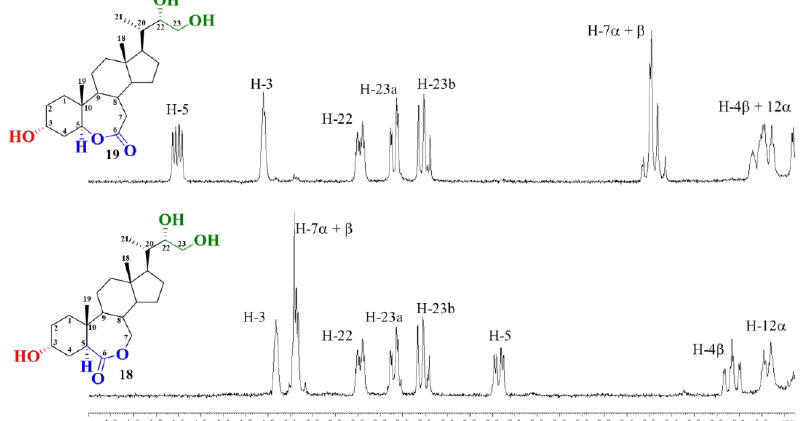
Figure 7. Major differences between chemical shift of hydrogens H-5 and H-7. Partial 1 H-NMR spectra (1.85–5.00 ppm) of lactones 2-Deoxybrassinosteroids 18 ( bottom ) and 19 ( top ).